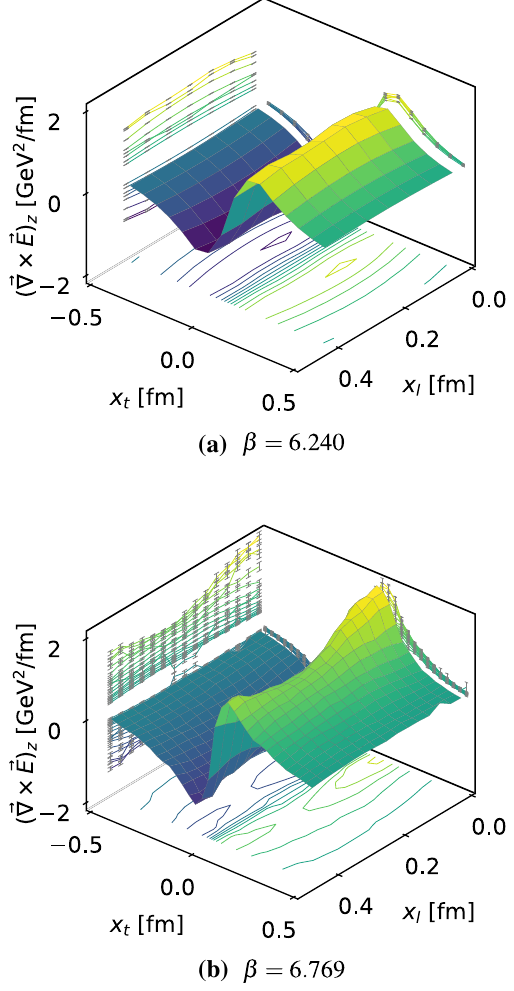
Fig. 8 Magnetic current ( ∇ × E ) z created by a quark–antiquark pair separated by d = 0 . 51 fm, for β = 6 . 240 ( a ) and β = 6 . 769 ( b